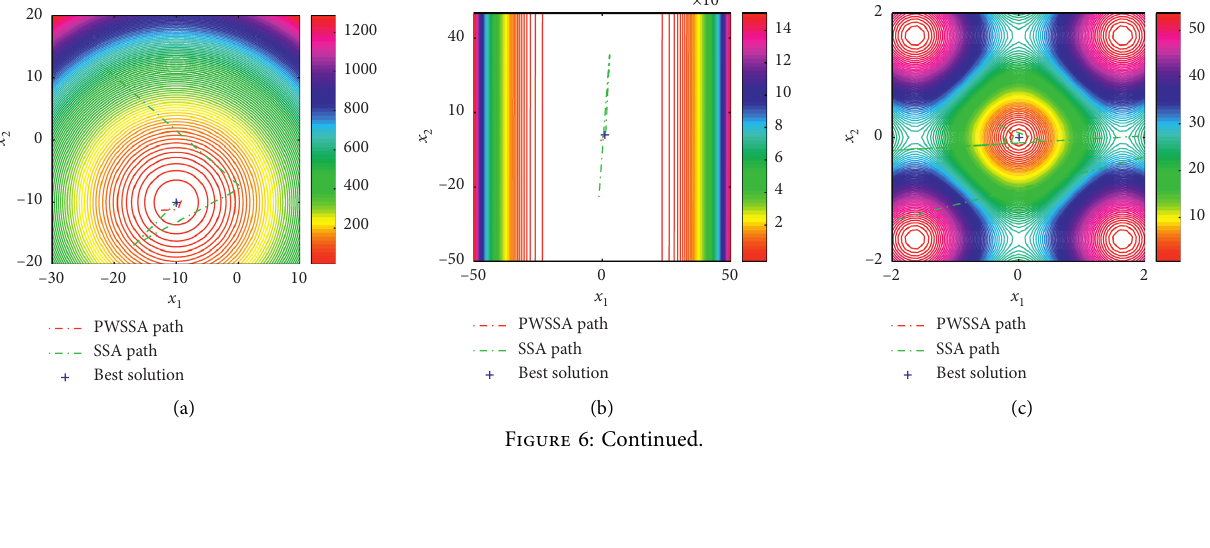
9( D � 100) . (b) f 10( D � 100) . (c) f 11( D � 100) . (d) f 12( D � 100)